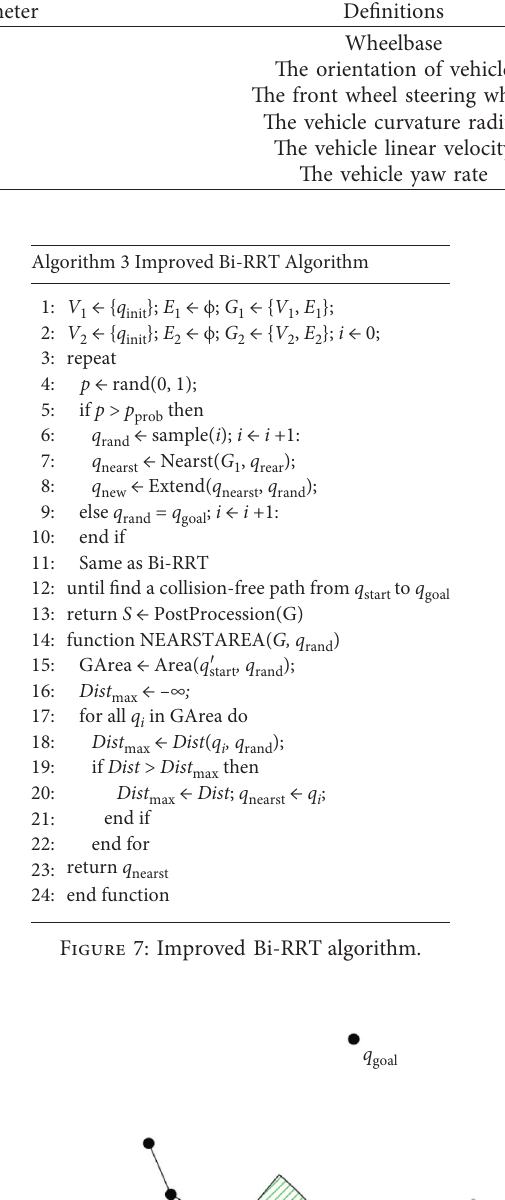
Table 1: The parameters of vehicle.